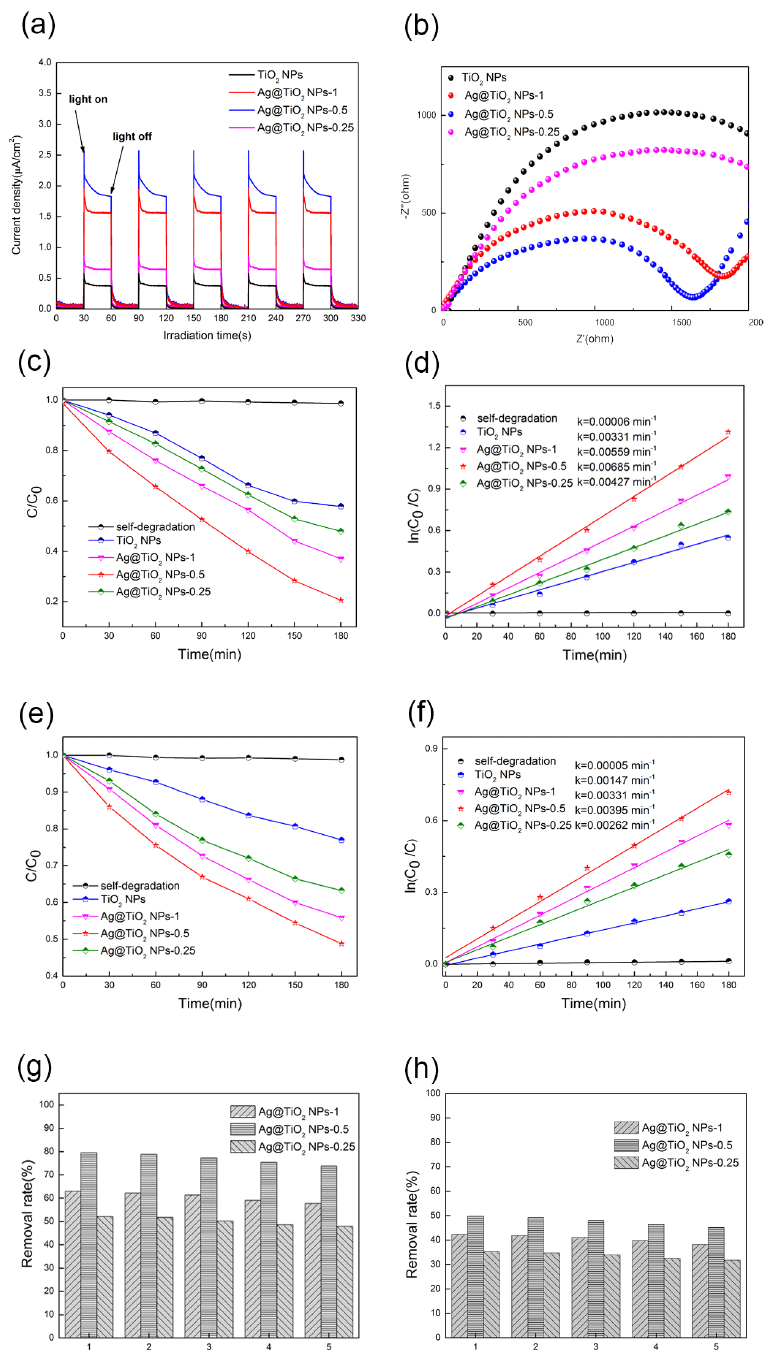
Figure 6. Photocurrent responses spectroscopy ( a ) and electrochemical impedance spectroscopy (EIS) ( b ) of the TiO 2 NPs and Ag@TiO 2 NPs samples; Methyl Orange (MO) photocatalytic degradation curves of the TiO 2 NPs and Ag@TiO 2 NPs samples under UV light ( c ); MO photocatalytic degradation Kinetic fit of the TiO 2 NPs and Ag@TiO 2 NPs samples under UV light ( d ); MO photocatalytic degradation curves of the TiO 2 NPs and Ag@TiO 2 NPs samples under Visible light ( e ); MO photocatalytic degradation Kinetic fit of the TiO 2 NPs and Ag@TiO 2 NPs samples under Visible light ( f ); Cycling performance of Ag@TiO 2 NPs samples for MO degradation under UV light ( g ); Cycling performance of Ag@TiO 2 NPs samples for MO degradation under Visible light ( h ).